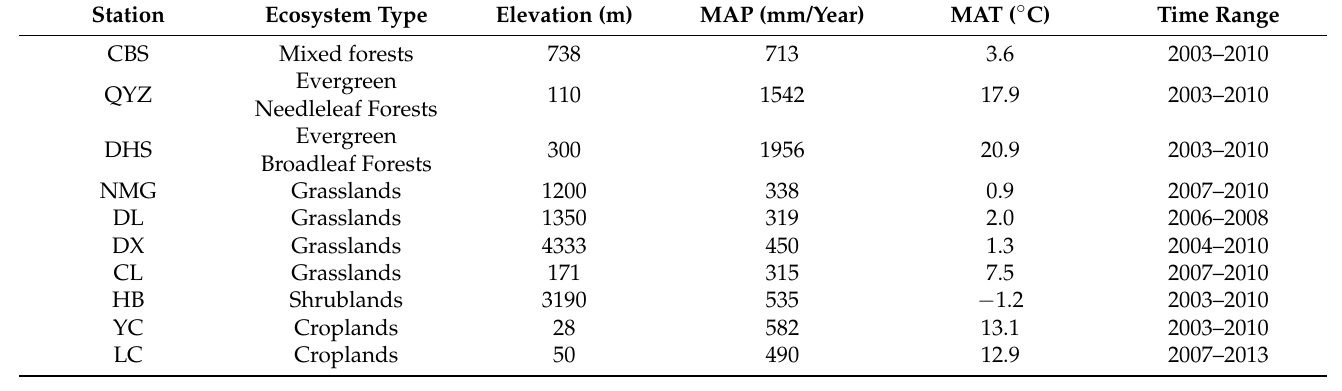
Table 3. The information on the ten flux sites. MAP: mean annual precipitation; MAT: mean annual temperature.